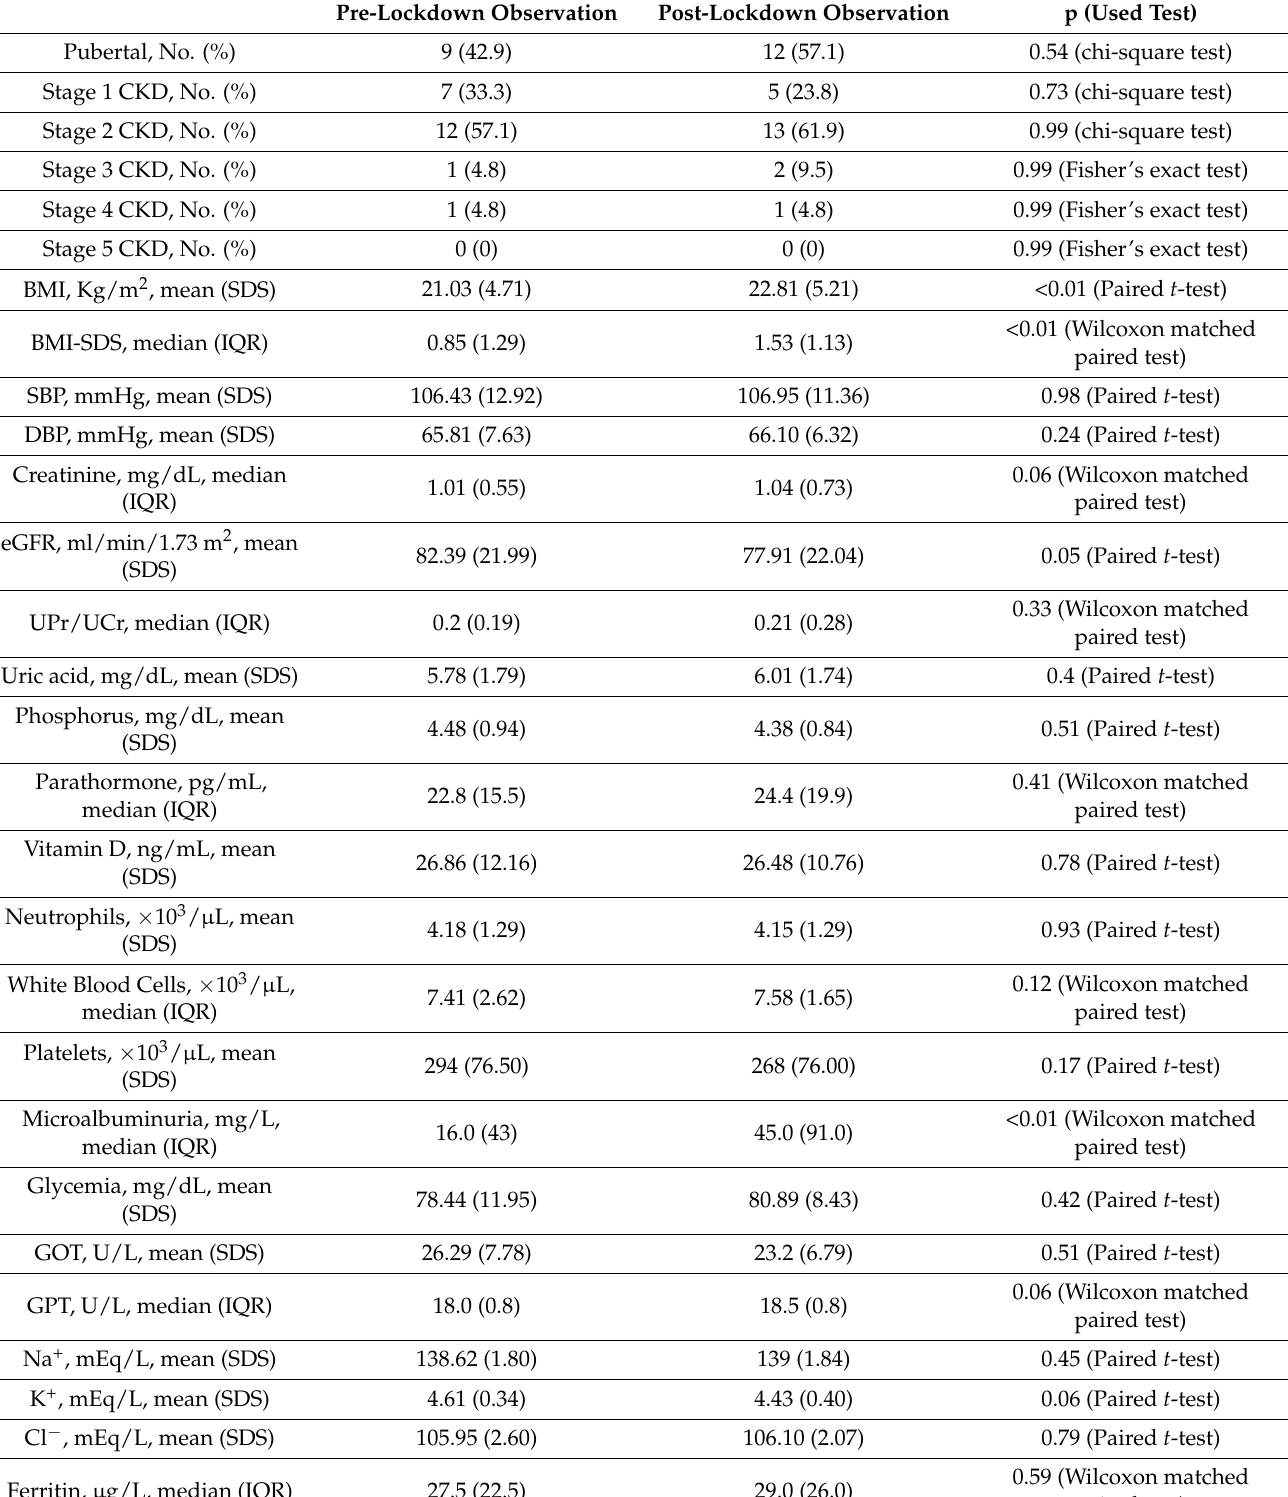
Table 1. Clinical and biochemical characteristics of all patients at pre- and post-lockdown observation. For continuous normally distributed variables mean ± SDS is shown, while for non-normally distributed variables median and interquartile range are